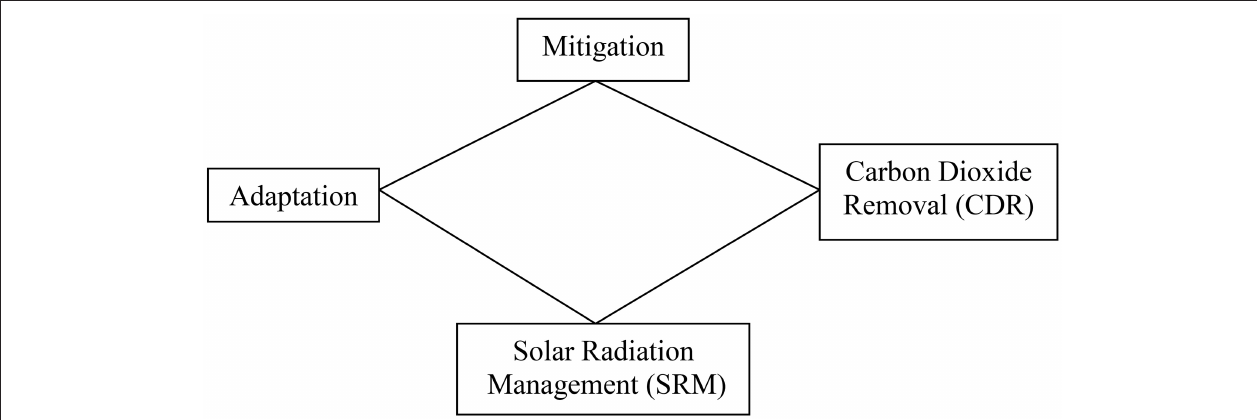
FIGURE 1 | Trapeze of strategies to respond to anthropogenic climate change.